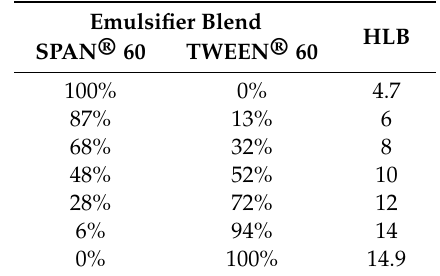
Table 2. Hydrophilic–lipophilic balance (HLB) values obtained combining di ff erent percentages of SPAN ® 60 and TWEEN ®